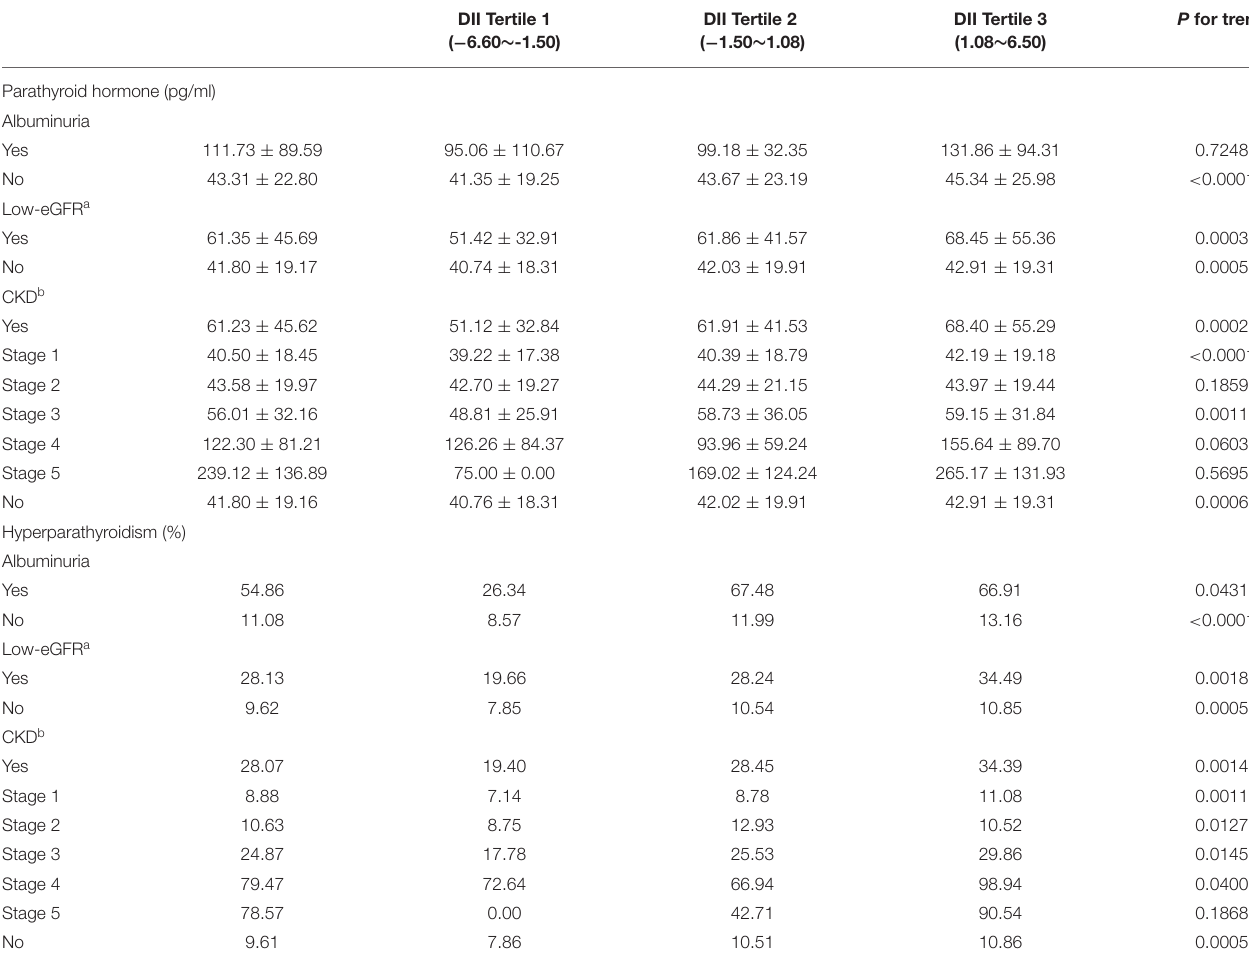
TABLE 2 | Parathyroid hormone (PTH) and the prevalence of hyperparathyroidism (HP) based on different renal population settings, weighted.